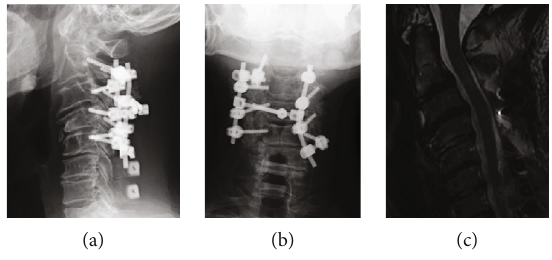
Figure 5: (a, b) Postoperative X-ray. X-ray shows C2-5 posterior fusion. Anterior spondylolisthesis of the axis was corrected. (c) Postoperative MRI image. MRI image shows that decompression had been performed and that the central cord de fi cit had been